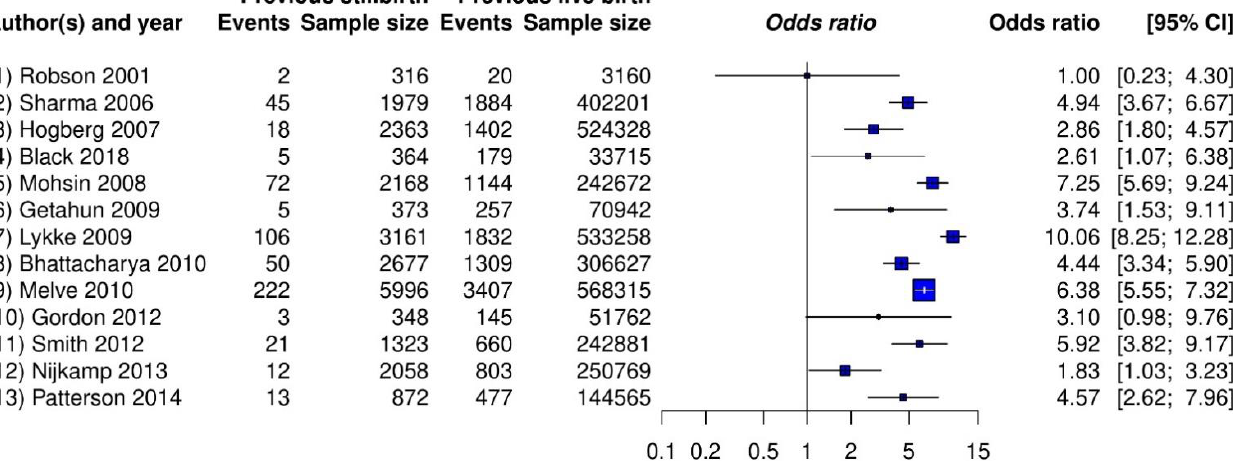
Figure 2. Forest plot of the meta-analysis on stillbirth (Example 1).